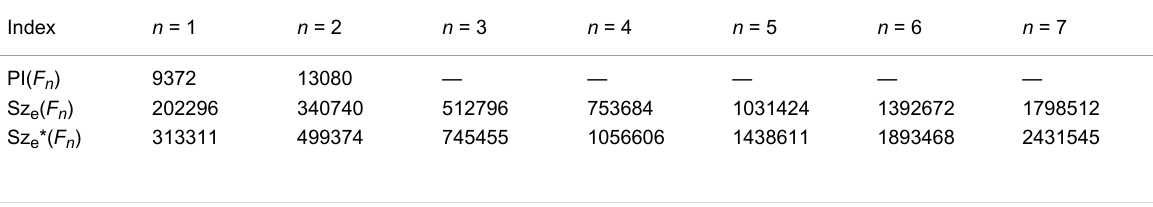
Table 2: The quantities, PI, edge Szeged and edge revised Szeged indices of F n , 1 ≤ n ≤ 7 .